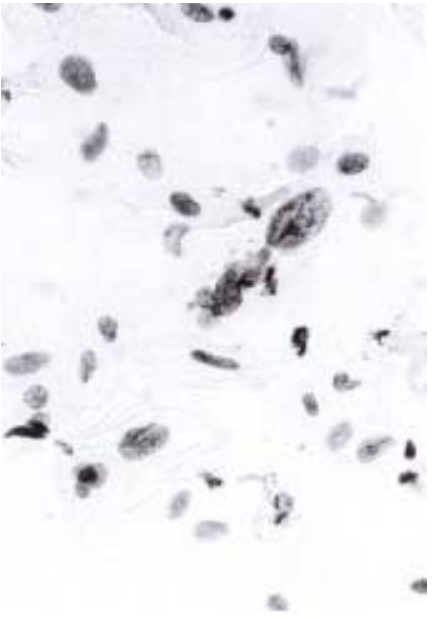
Fig. 9. Few abnormal cells from a squamous cell carcinoma showing coarse chromatin and prominent nucleoli in polymorphic nuclei of variable size. Patient D. Original magnification 630 ×